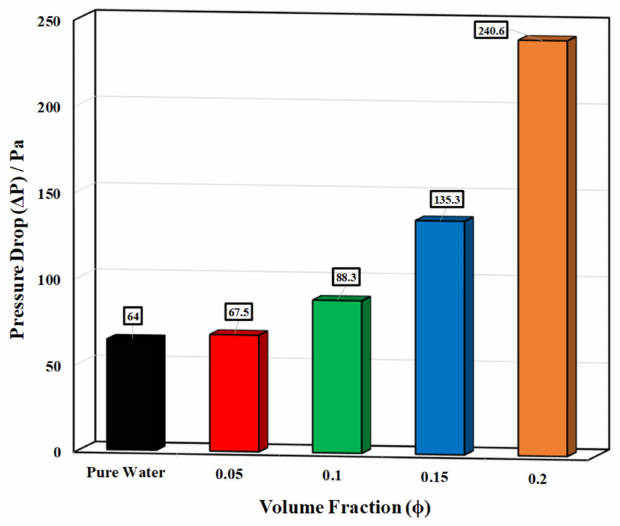
Figure 13. Pressure drop when using Ag-MgO/water hybrid nanofluid with different volume fractions at Re =